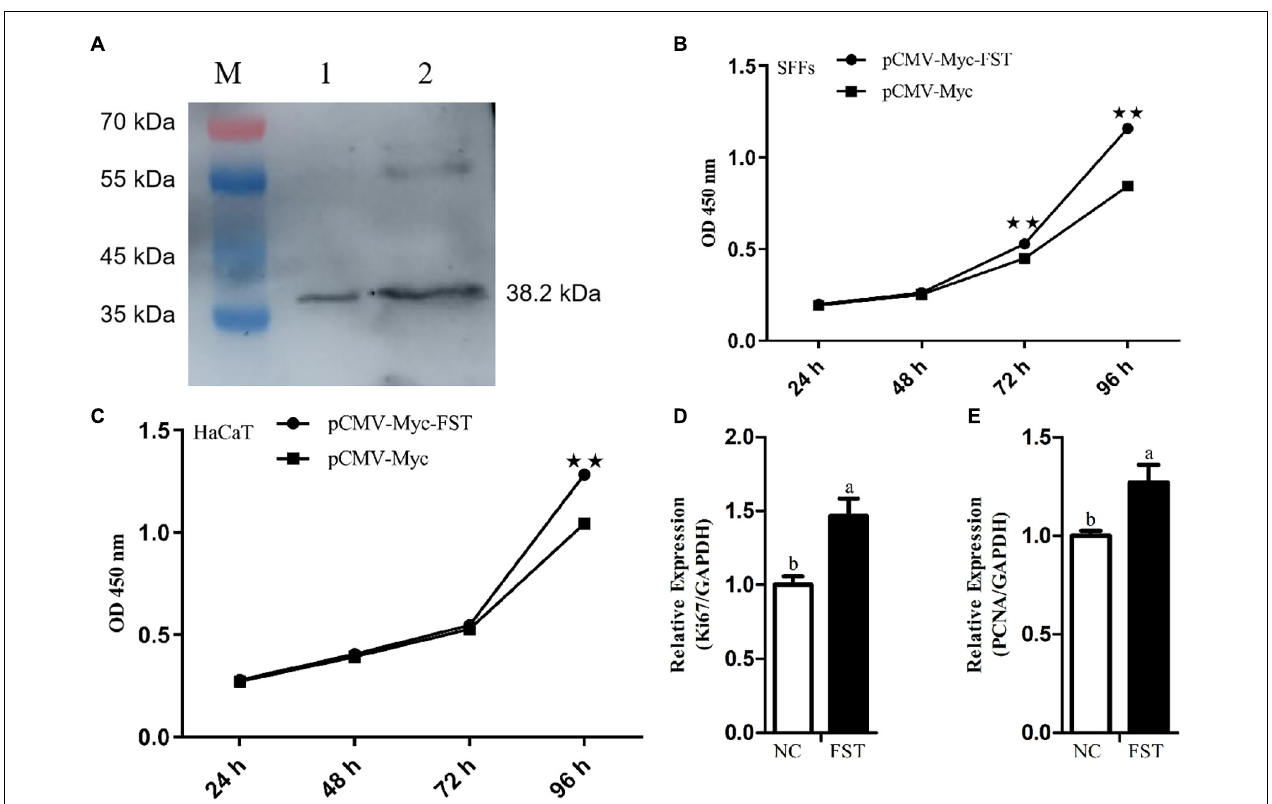
FIGURE 2 | Effects of FST overexpression on cell proliferation. (A) Western blot recognition of the FST expression vector (pCMV-Myc-FST). Lanes 1 and 2: the lysate of the cells transfected with pCMV-Myc-FST (38.2 kDa). (B,C) Effects of FST overexpression on the proliferation of SFFs and HaCaT cells. (D,E) Expression of Ki67 and PCNA in the SFFs transfected with pCMV-Myc-FST. Fold change was calculated referring to the expression of the SFFs transfected with pCMV-Myc at 48 h. All data are representative of three independent experiments and display as the mean ± SEM. For each figure layer, statistical significance was indicated by * P < 0.05, ** P < 0.01, and different letters above error bars indicated a statistical significance ( P <